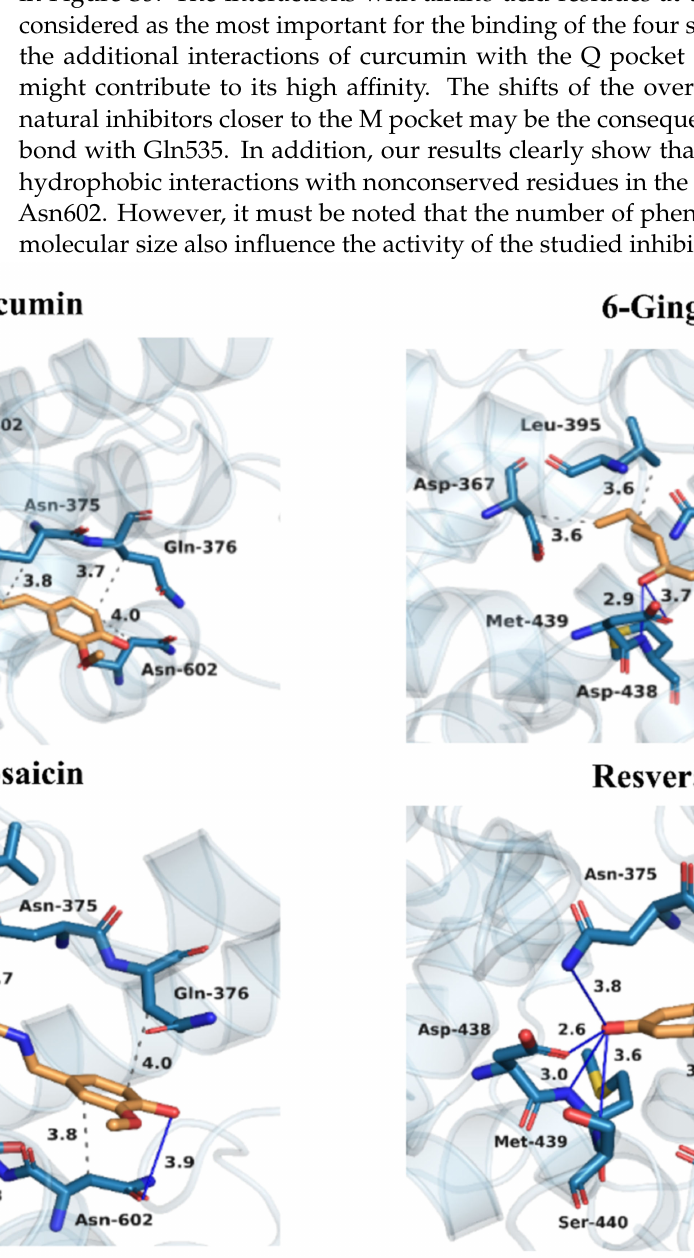
Figure 5. Binding modes of curcumin, 6-gingerol, capsaicin, and resveratrol at the active site of PDE4D. Carbon atoms of the investigated polyphenols are presented in orange and carbon atoms of PDE4D amino-acid residues in light blue color. Oxygen atoms are red, nitrogen atoms dark blue, and sulfur atoms yellow. Hydrophobic interactions are depicted with gray and hydrogen bonds with dark blue lines. All distances are given in Å and represent averages over all MD production run snapshots for each complex. Hydrogen atoms are omitted for